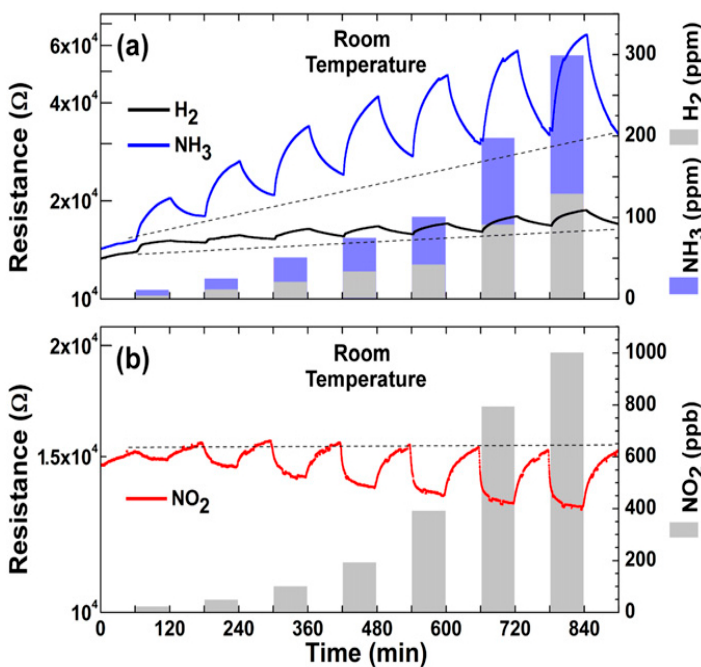
Figure 23. Panel ( a ): RT sensing responses of exfoliated BP flakes to H 2 (black curve) and NH 3 (blue curve); Panel ( b ): RT sensing responses of exfoliated BP flakes to NO 2 . (Reproduced with permission from [212], © IOP Publishing, Bristol, United Kingdom. Reproduced with all permission. All rights reserved).